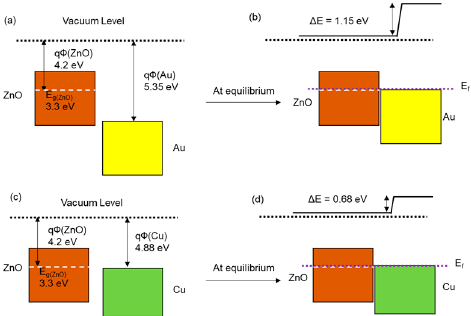
Figure 7. ( a ) Energy levels of ZnO and Au; ( b ) formation of heterojunction barrier. ( c ) Energy levels of ZnO and Cu; ( d ) formation of heterojunction barrier.